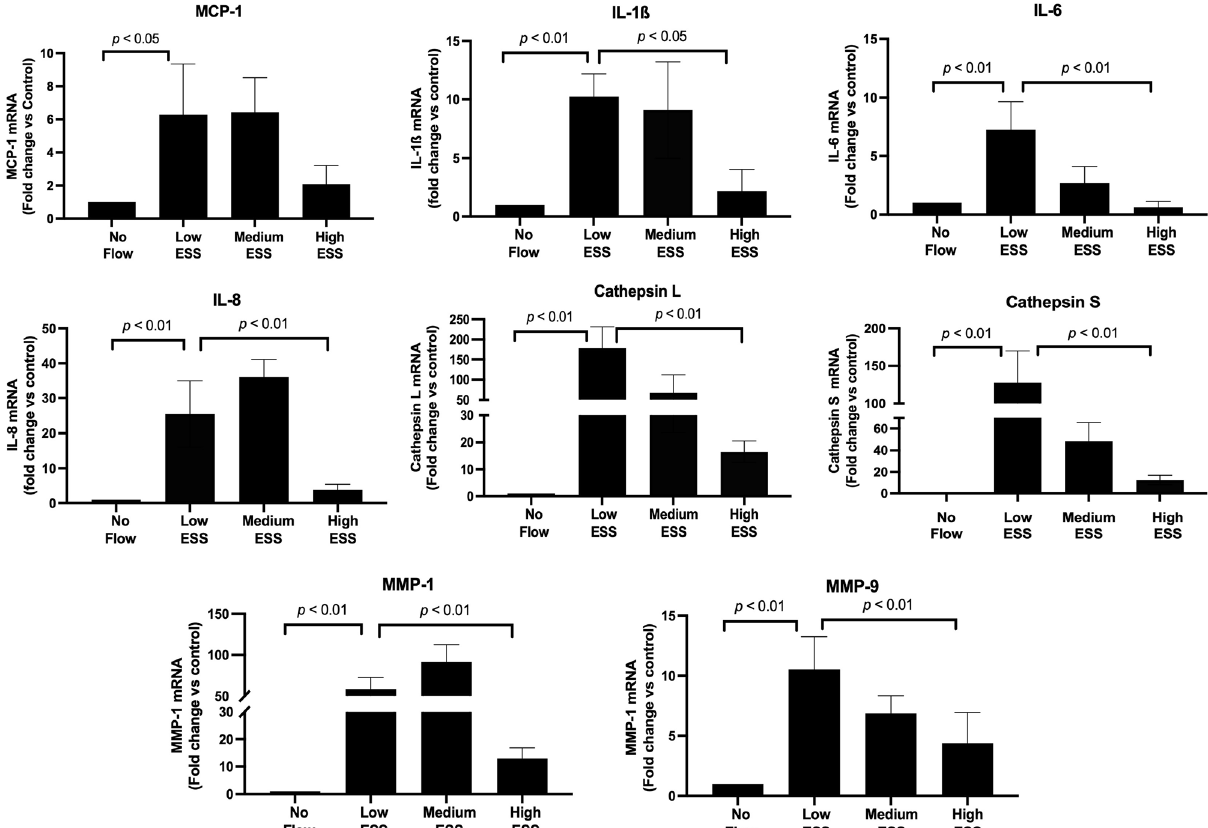
Figure 2. Effect of various shear stress conditions on the mRNA expression of inflammatory molecules and matrix-degrading enzymes in the co-cultures. 3D co-culture of HCAECs, HCASMCs, and monocytes (THP-1) cells were prepared on the cover slips and exposed to low ESS, medium ESS, high ESS, or no flow (control) for 1 h followed by additional culture for 1 h. Total RNA was extracted and expression of mRNA was quantified by real time RT-PCR as described in the “Methods”. IL: interleukin, ESS: endothelial shear stress, MMP: matrix metalloproteinase, MCP-1: monocyte chemoattractant protein-1, HCAECs: human coronary artery endothelial cells, HCASMCs: human coronary artery smooth muscle cells. Data were averaged over 3 separate